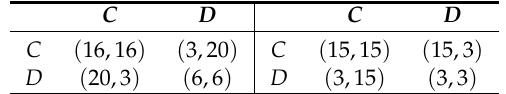
Table 3. Utilities for PD (left) and SG (right) in Example